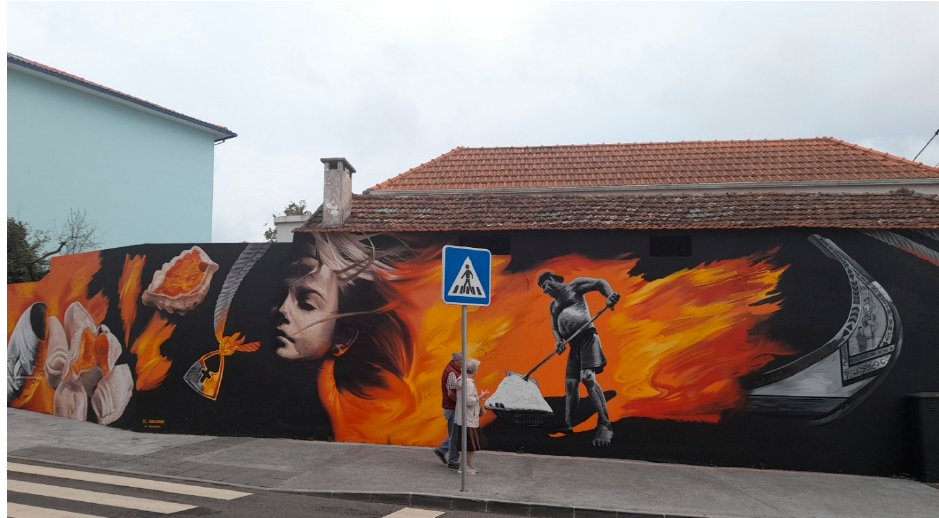
Figure 8. Aveiro’s identitary elements, by Fábio Carneiro, 2021 (Source: author’s own photos, 2022).